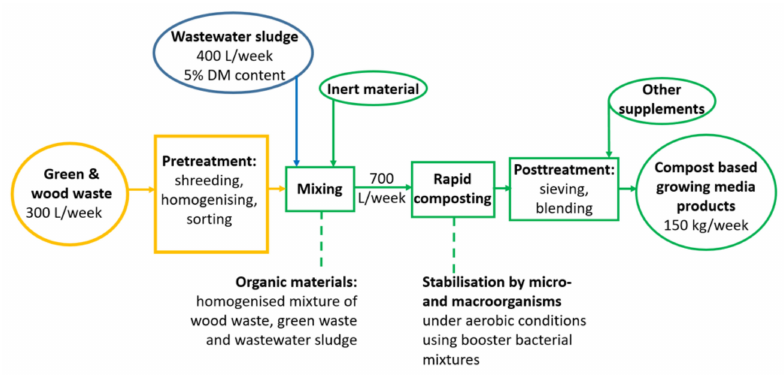
Figure 7. Flow scheme of the